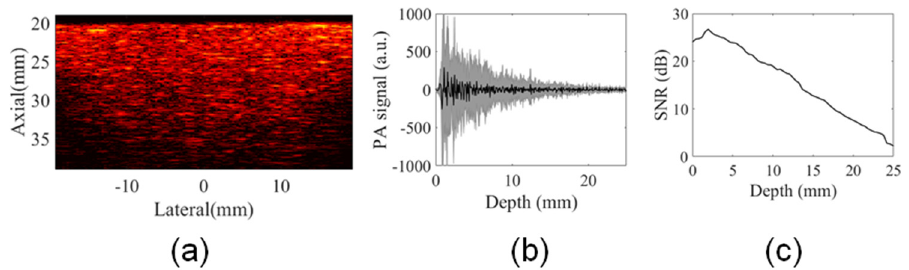
Figure 10. ( a ) Final PA image of a single image slice of the phantom, ( b ) PA signal profile of this PA